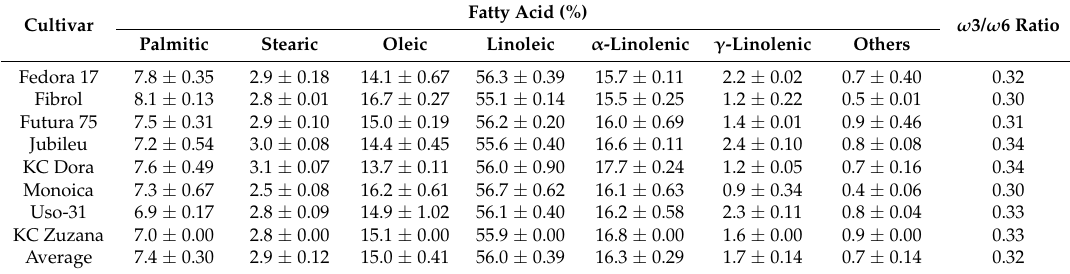
Table 6. Oil fatty acid composition of hemp cultivars studied. Results are means ± SE. ω 3/ ω 6 ratio is